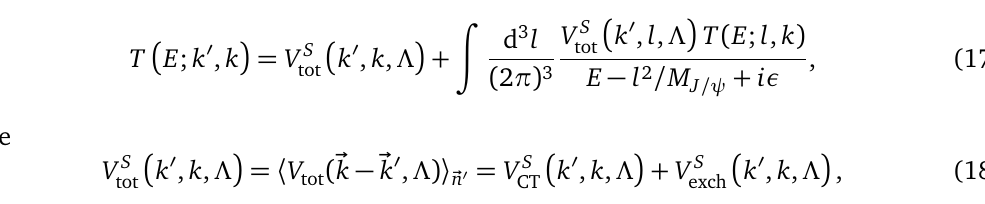
Figure 7: The behaviour of the regularised potentials V π ( r , Λ ) and V Eq. (12)) as functions of r for the cut-off Λ = 2 GeV. Adapted from Ref. [ 3 ] under attribution 4.0 International license (CC BY